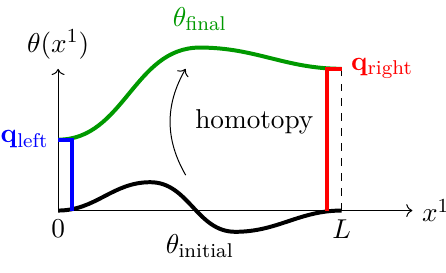
Figure 4 . Boundary brane charge contribution to the topological